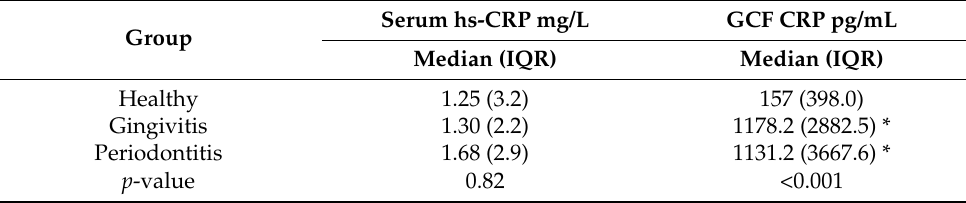
Table 2. C-reactive protein levels in serum and gingival crevicular fluid of study participants. Serum hs-CRP mg/L GCF CRP pg/mL Group Median (IQR) Median (IQR) Healthy